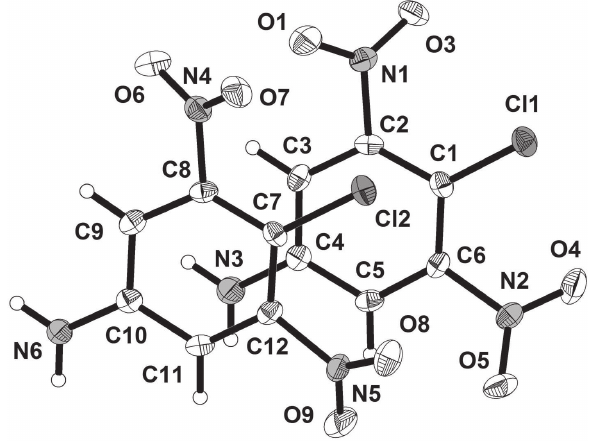
Table 2: Fractional atomic coordinates and isotropic or equivalent isotropic displacement parameters (Å 2